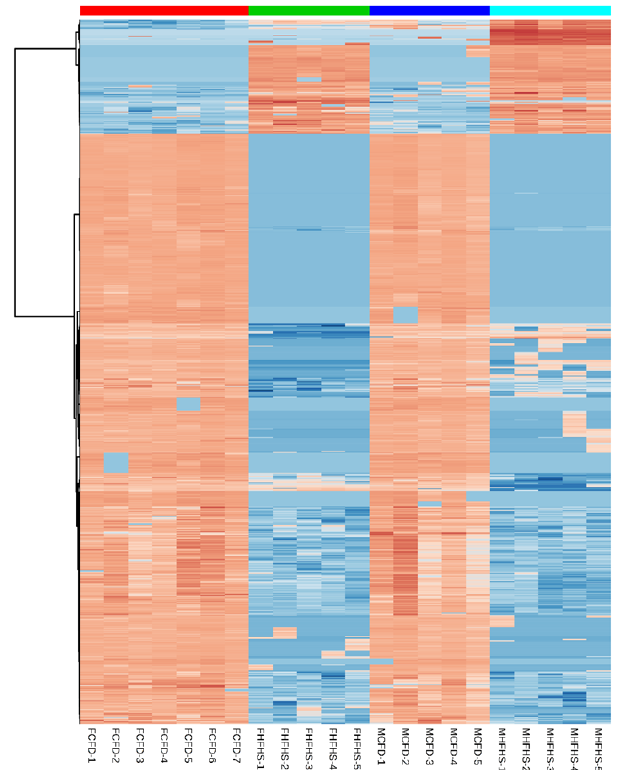
four-fold greater).